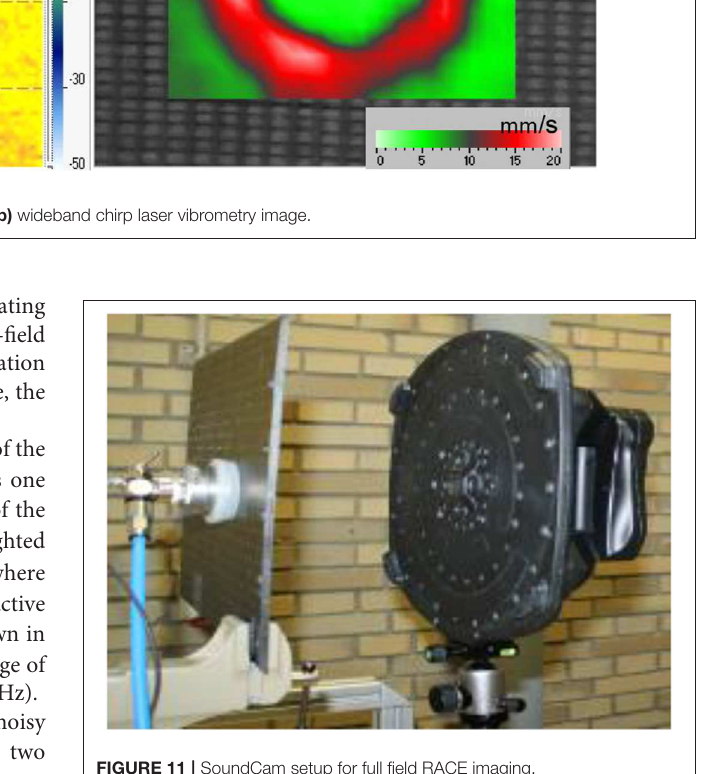
FIGURE 11 | SoundCam setup for full field RACE